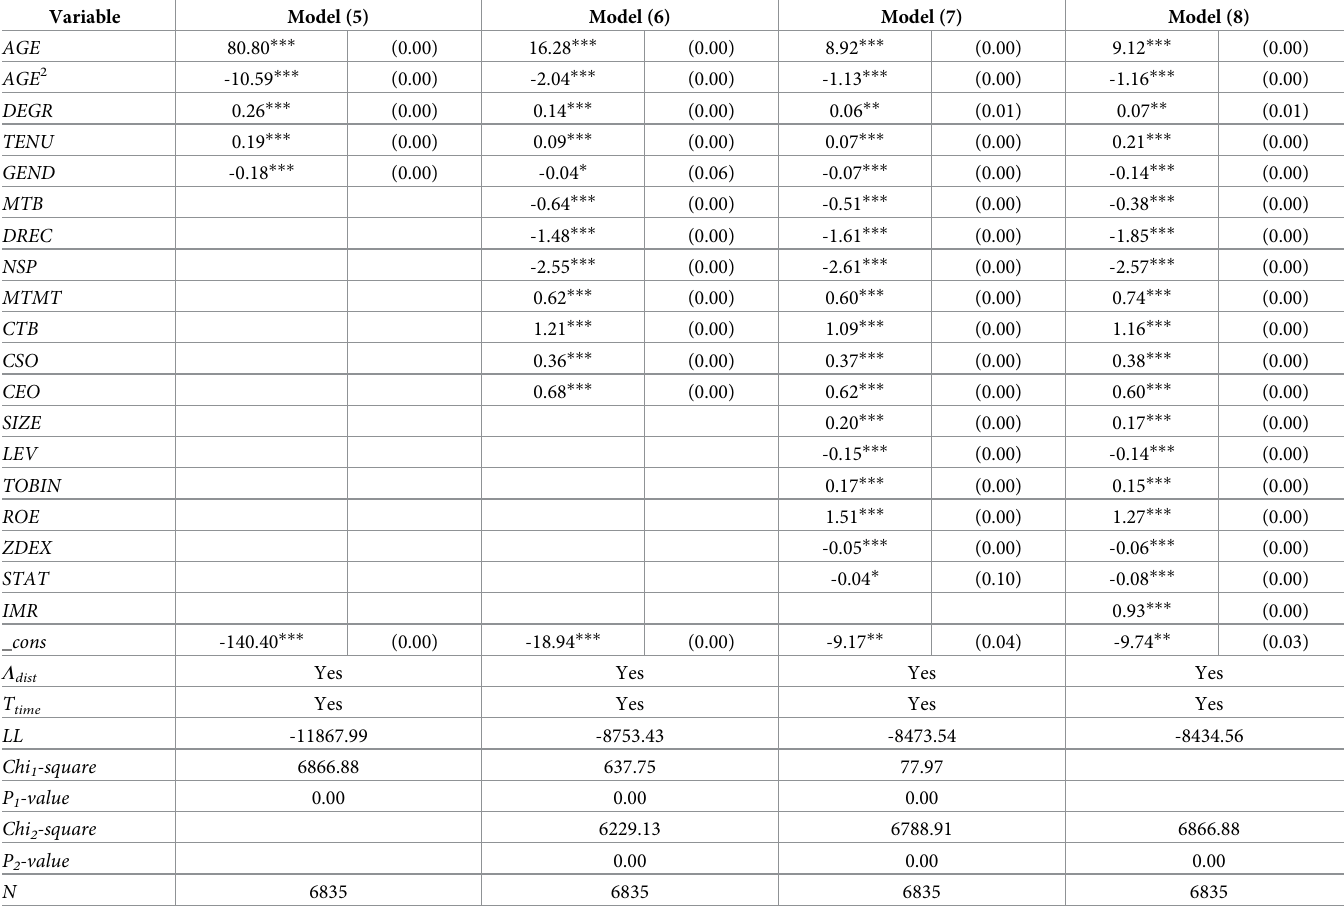
Table 4. The regression results of two-tier stochastic frontier and endogenous correction model. Variable